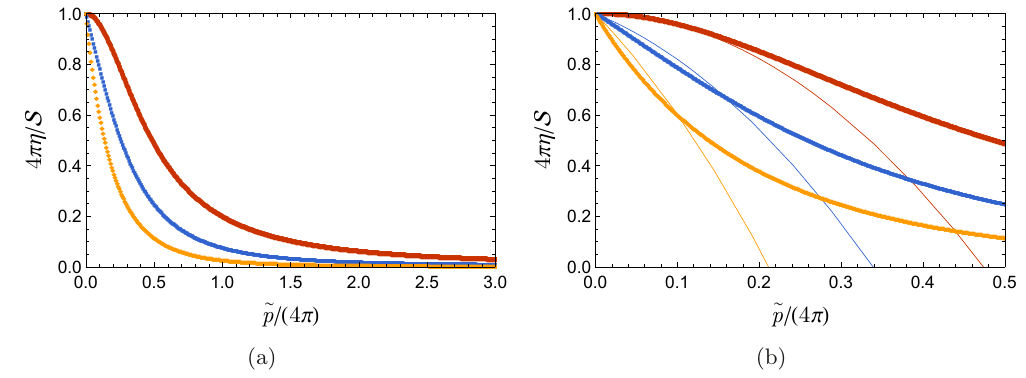
Figure 3 . In subfigure (a) we exhibit 4 πη/ vs. ˜ p/ (4 π ) by using numerical methods to solve (4.63). S The thick red line stands for the ratio in the linear axion model, the thick blue line is for α = 0 . 2, and the thick yellow one is for α = 0 . 5. In subfigure (b) we compare the numerical results to the high temperature approximations, up to order ˜ p 2 . Thick lines are as in subfigure (a), whereas the thin ones depict the approximation with the color pattern being the same as in subfigure